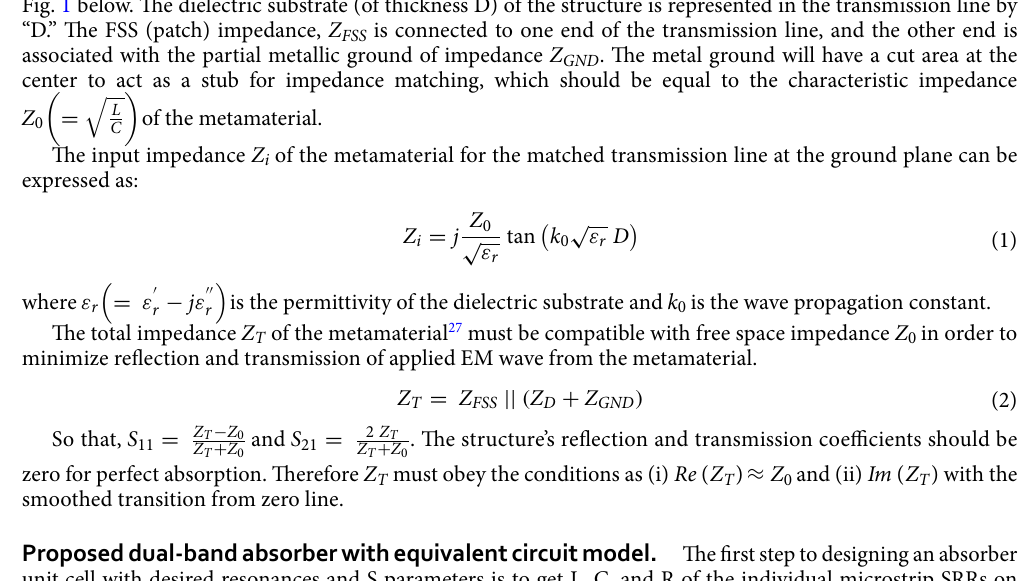
and discussion, respectively. Finally, a conclusion and comparing the proposed absorber’s performance indicators with other WiFi absorbers have established the proposed design as the best WiFi absorber that comprehends with appropriate equivalent circuit analysis.